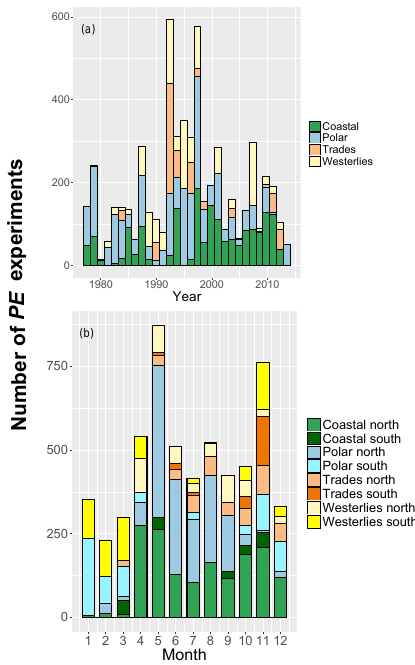
Figure 5. The number of P - E experiments in the MAPPS database for the four Longhurst oceanic domains by (a) year and (b) month and hemisphere (north and